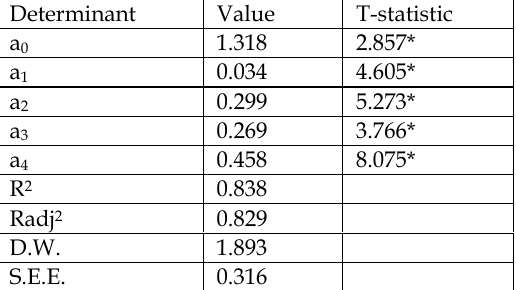
Table 1: Production function